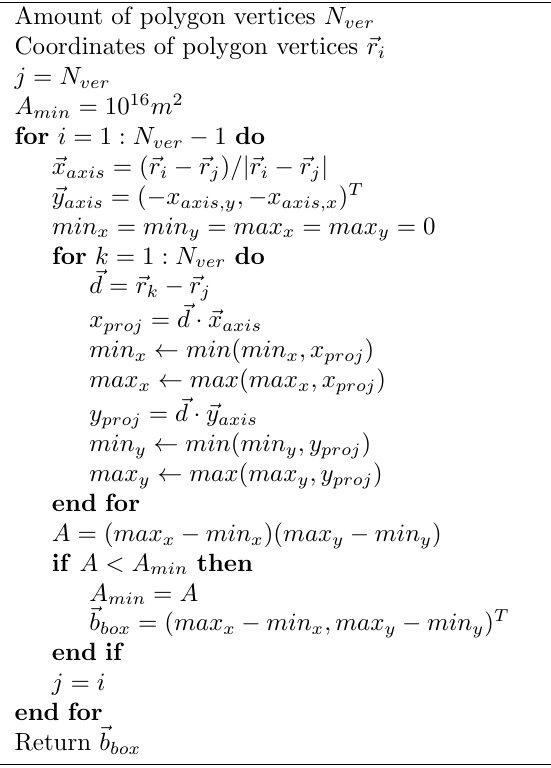
Algorithm 9 Object-aligned bounding box in 2D. Amount of polygon vertices N ver